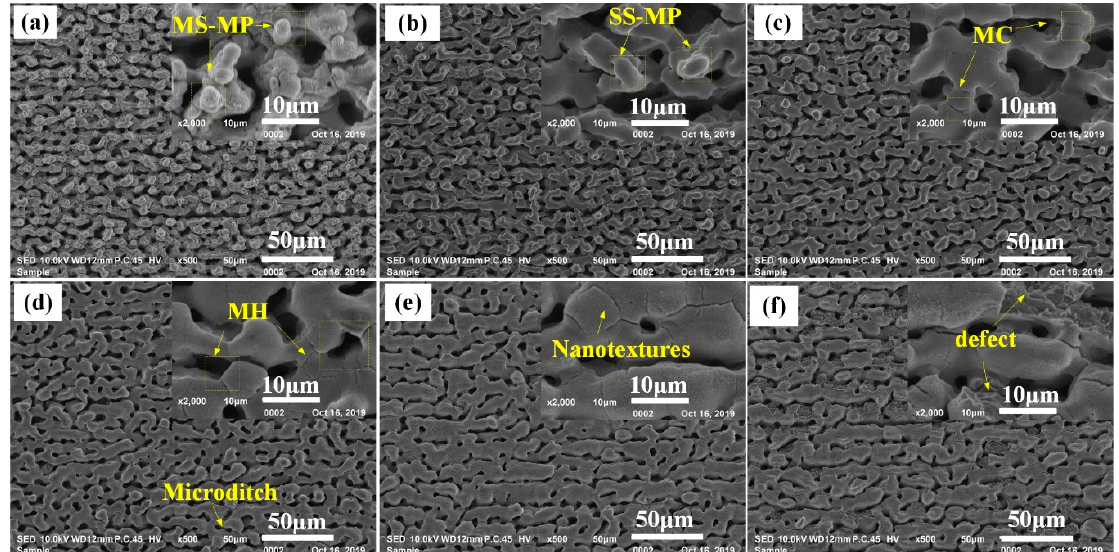
Figure 5. Morphology evolution of the surfaces irradiated by the two-step laser process with Fp1 = 4.0 J/cm 2 and various F p2 . ( a ) F p2 = 0.0 J/cm 2 ; ( b ) F p2 = 1.1 J/cm 2 ; ( c ) F p2 = 1.5 J/cm 2 ; ( d ) F p2 = 1.9 J/cm 2 ; ( e ) Fp1 = 4.0 J / cm 2 and various F p2 . ( a ) F p2 = 0.0 J / cm 2 ; ( b ) F p2 = 1.1 J / cm 2 ; ( c ) F p2 = 1.5 J / cm 2 ; F p2 = 2.4 J/cm 2 ; ( f ) F p2 = 2.9 J/cm 2 . ( d ) F p2 = 1.9 J / cm 2 ; ( e ) F p2 = 2.4 J / cm 2 ; ( f ) F p2 = 2.9 J / cm 2